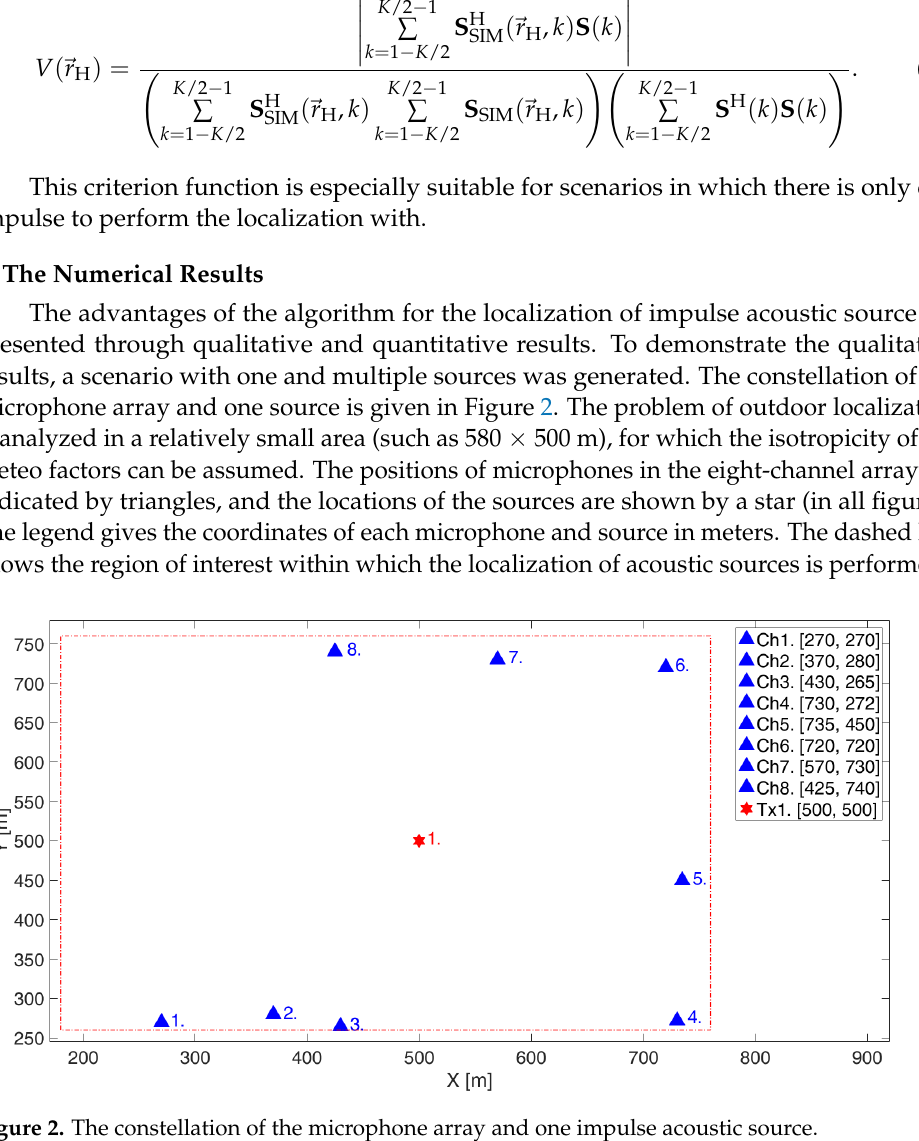
Figure 2. The constellation of the microphone array and one impulse acoustic